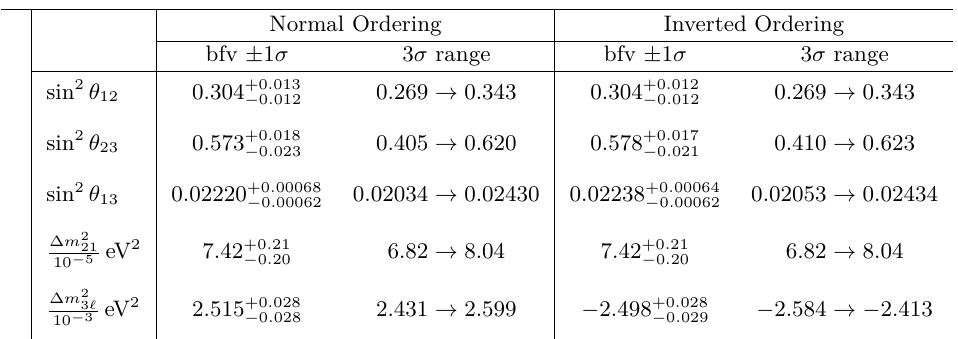
Table 5 . Neutrino oscillation parameters taken from ref. [199]. Here, ∆ m 2 ∆ m 2 < 0 for IH. Here ‘bfv’ represents best fit values obtained from global fit 32